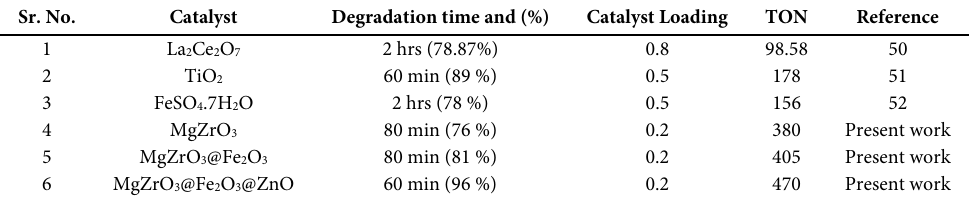
Table. 1. Comparative study of catalysts for degradation of Nigrosin Sr. No.